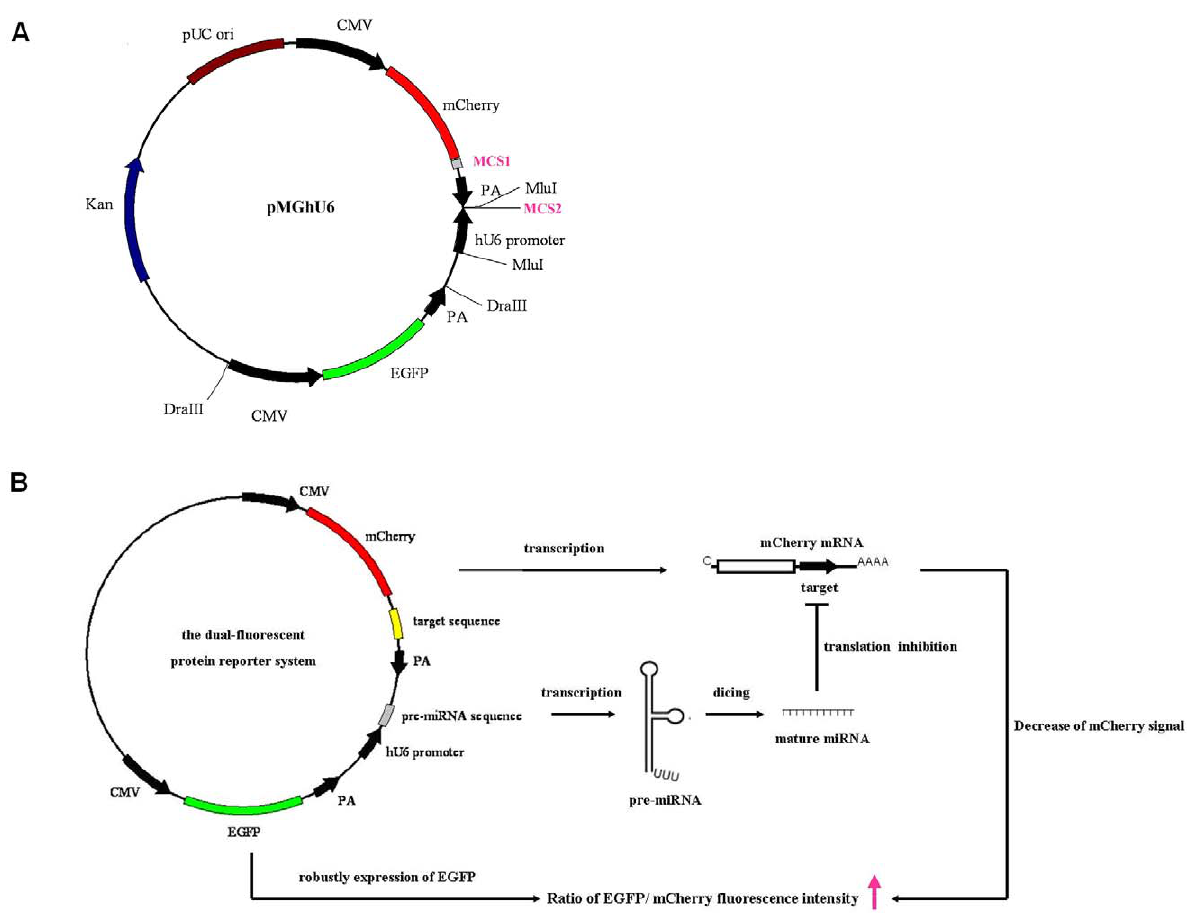
Figure 1. The construction and principle behind the dual-fluorescent protein reporter vector. (A) A diagram of the dual-fluorescent protein reporter vector pMGhU6. (B) The principle of the dual-fluorescent protein reporter vector system.